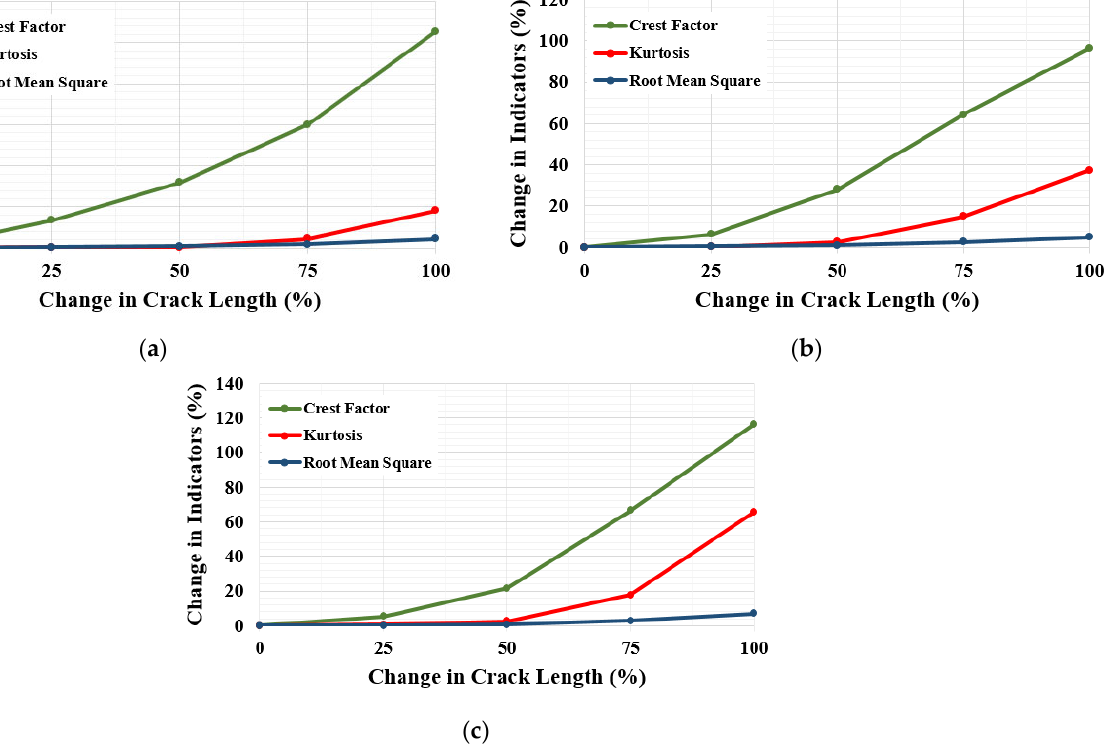
Figure 19. The percentage change of statistical indicators evaluated within the scope of the present study: ( a ) 20°/20°; ( b ) 20°/25°; ( c ) 20°/30°.